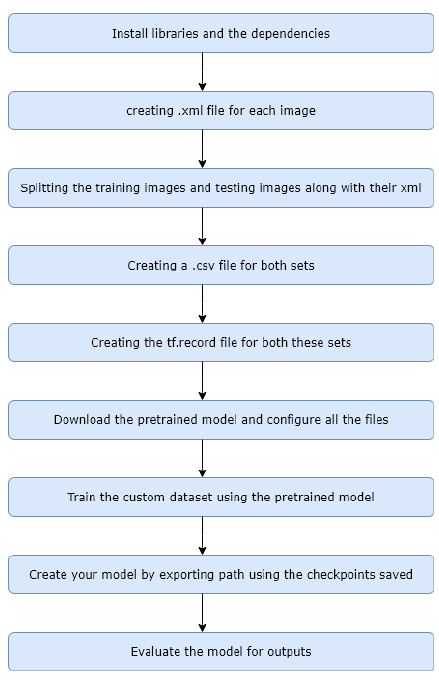
Figure 2. Tensorflow object detection flowchart to train